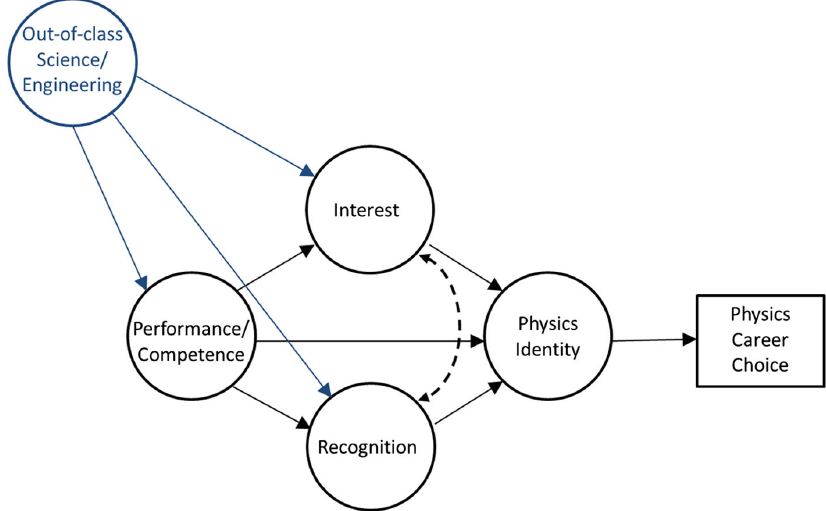
FIG. 1. Proposed structural model for the SEM analysis of the relationships between the identity dimensions, physics career choice, and out-of-class science and engineering activities.